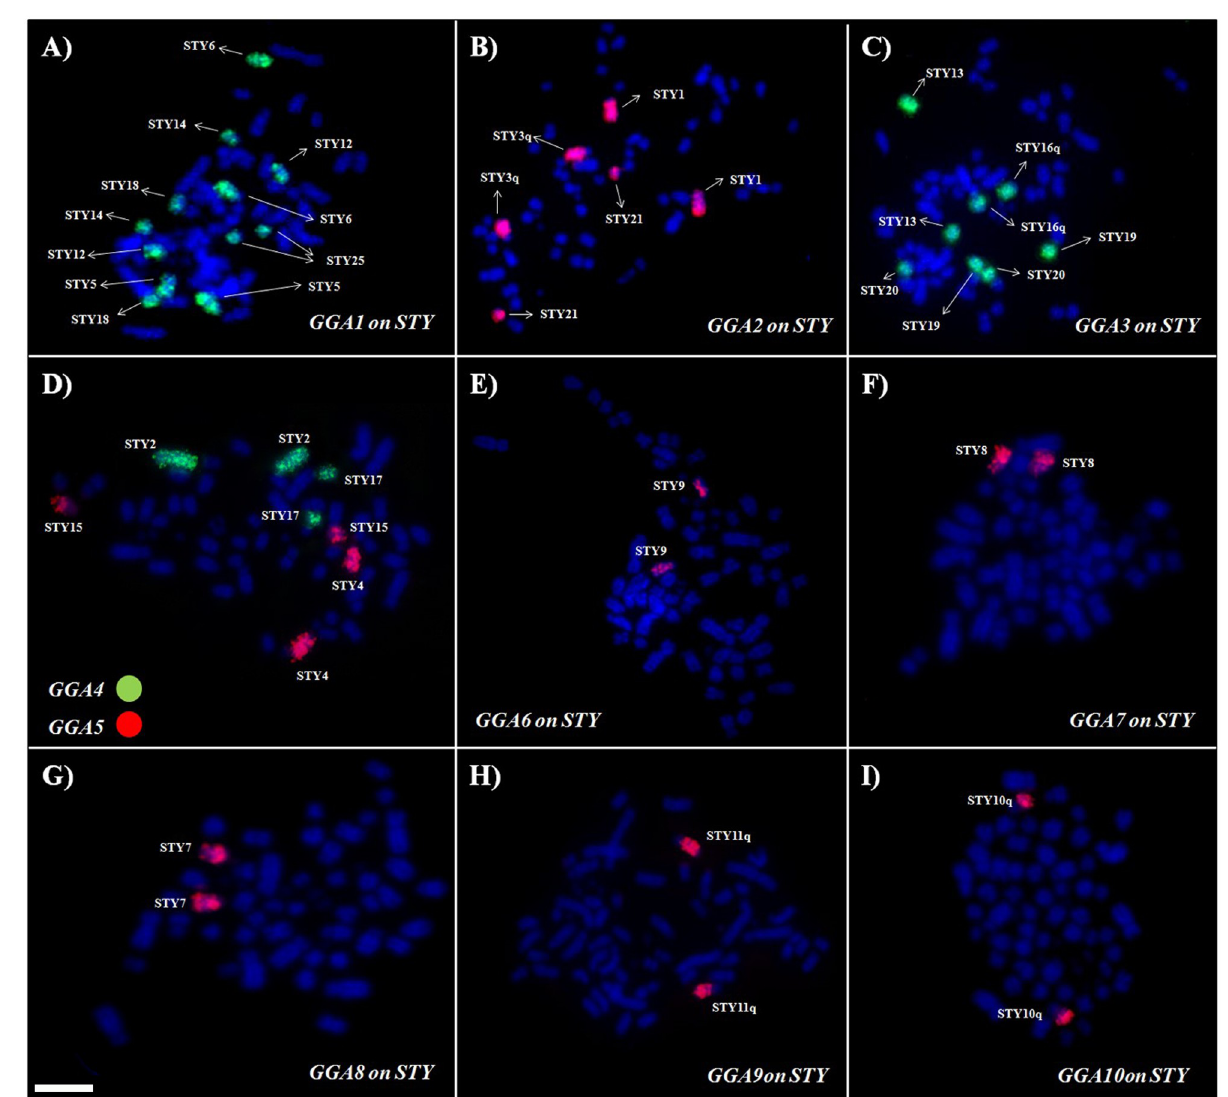
Fig 2. Representative results of FISH experiments using G . gallus chromosome-specific probes corresponding to pairs GGA1 to GGA5 in S . tyrannus karyotype. Red and green signals represent probes labelled with Cy3 or FITC, respectively. Scale bar: 5 μ m.